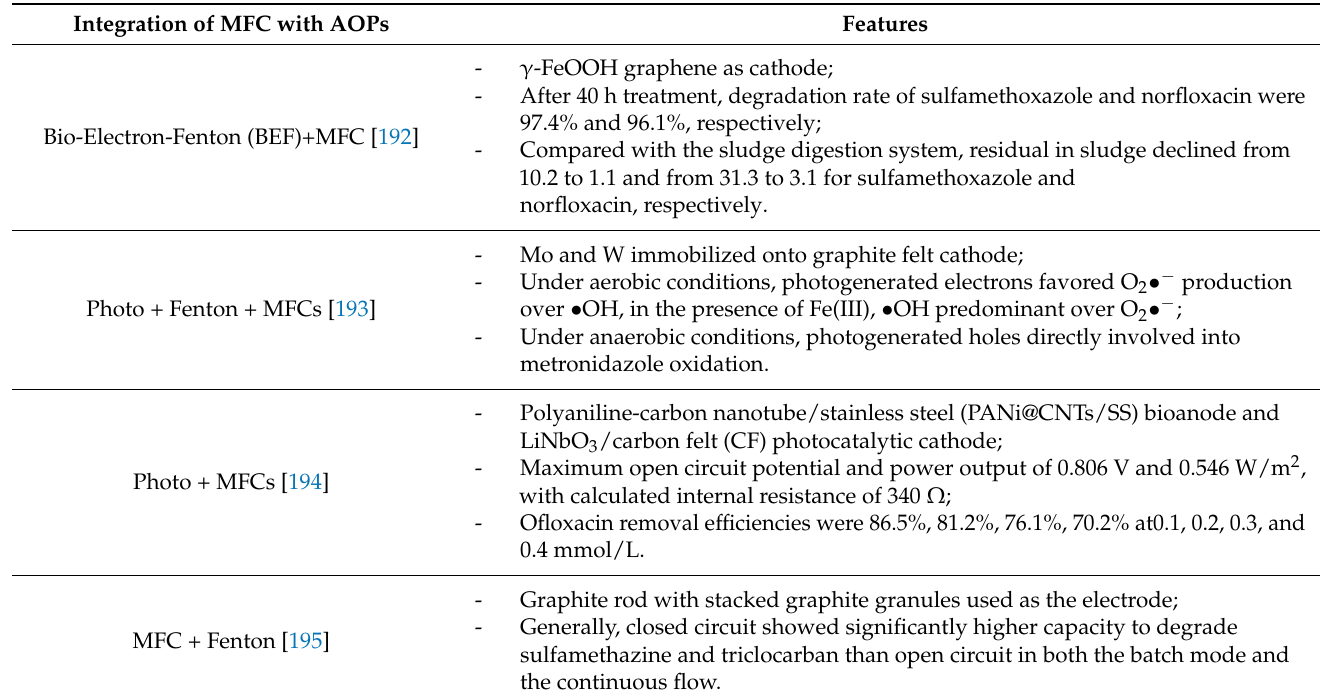
Table 5. Studies on the antibiotic removal by the hybrids between MFCs and